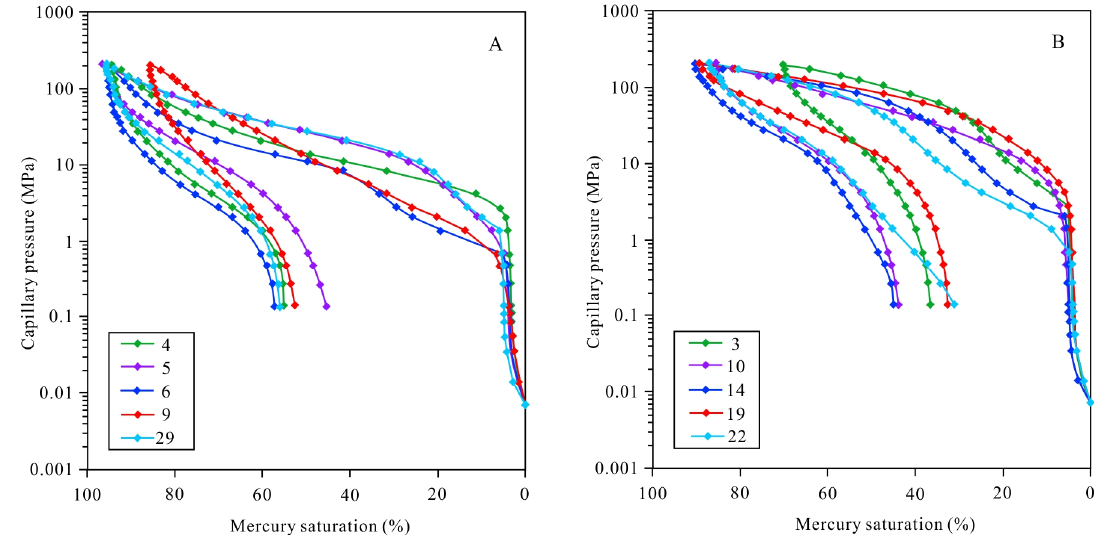
Figure 6. ( A ) HPMI curve of samples with Pore-lining chlorite. ( B ) HPMI curve of samples without Pore-lining chlorite.